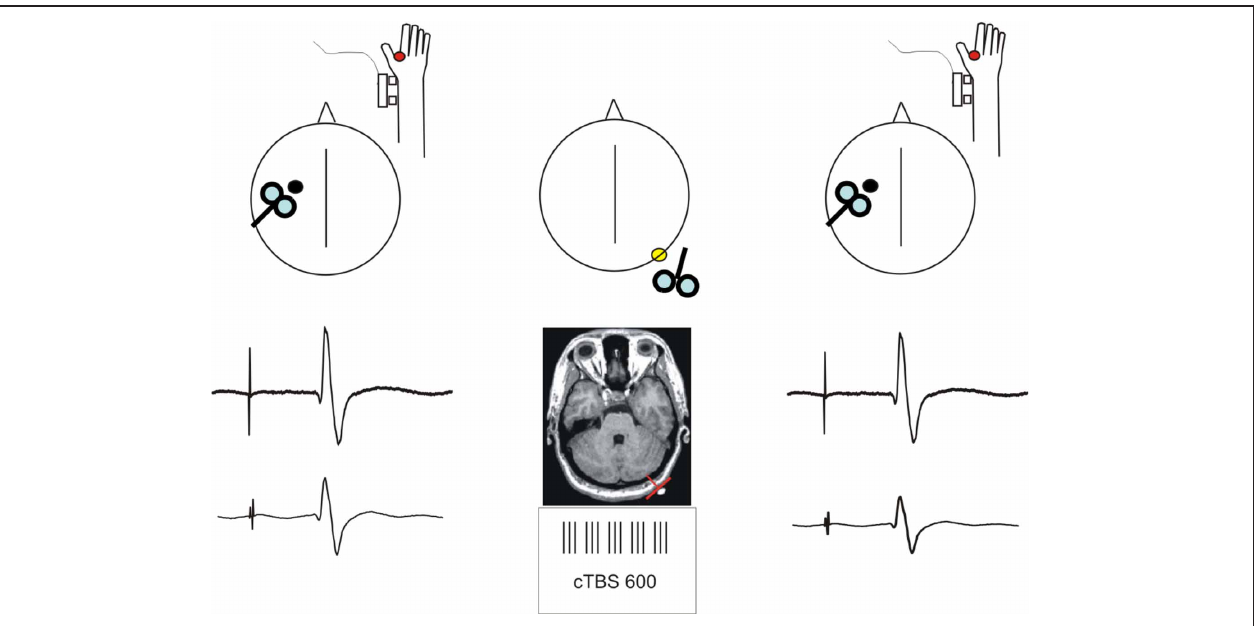
FIGURE 1 | Schematic description of the experimental procedure. Short-latency afferent inhibition (SLAI) was recorded by measuring the inhibitory effects ofthe peripheral median nerve stimulation over the amplitude